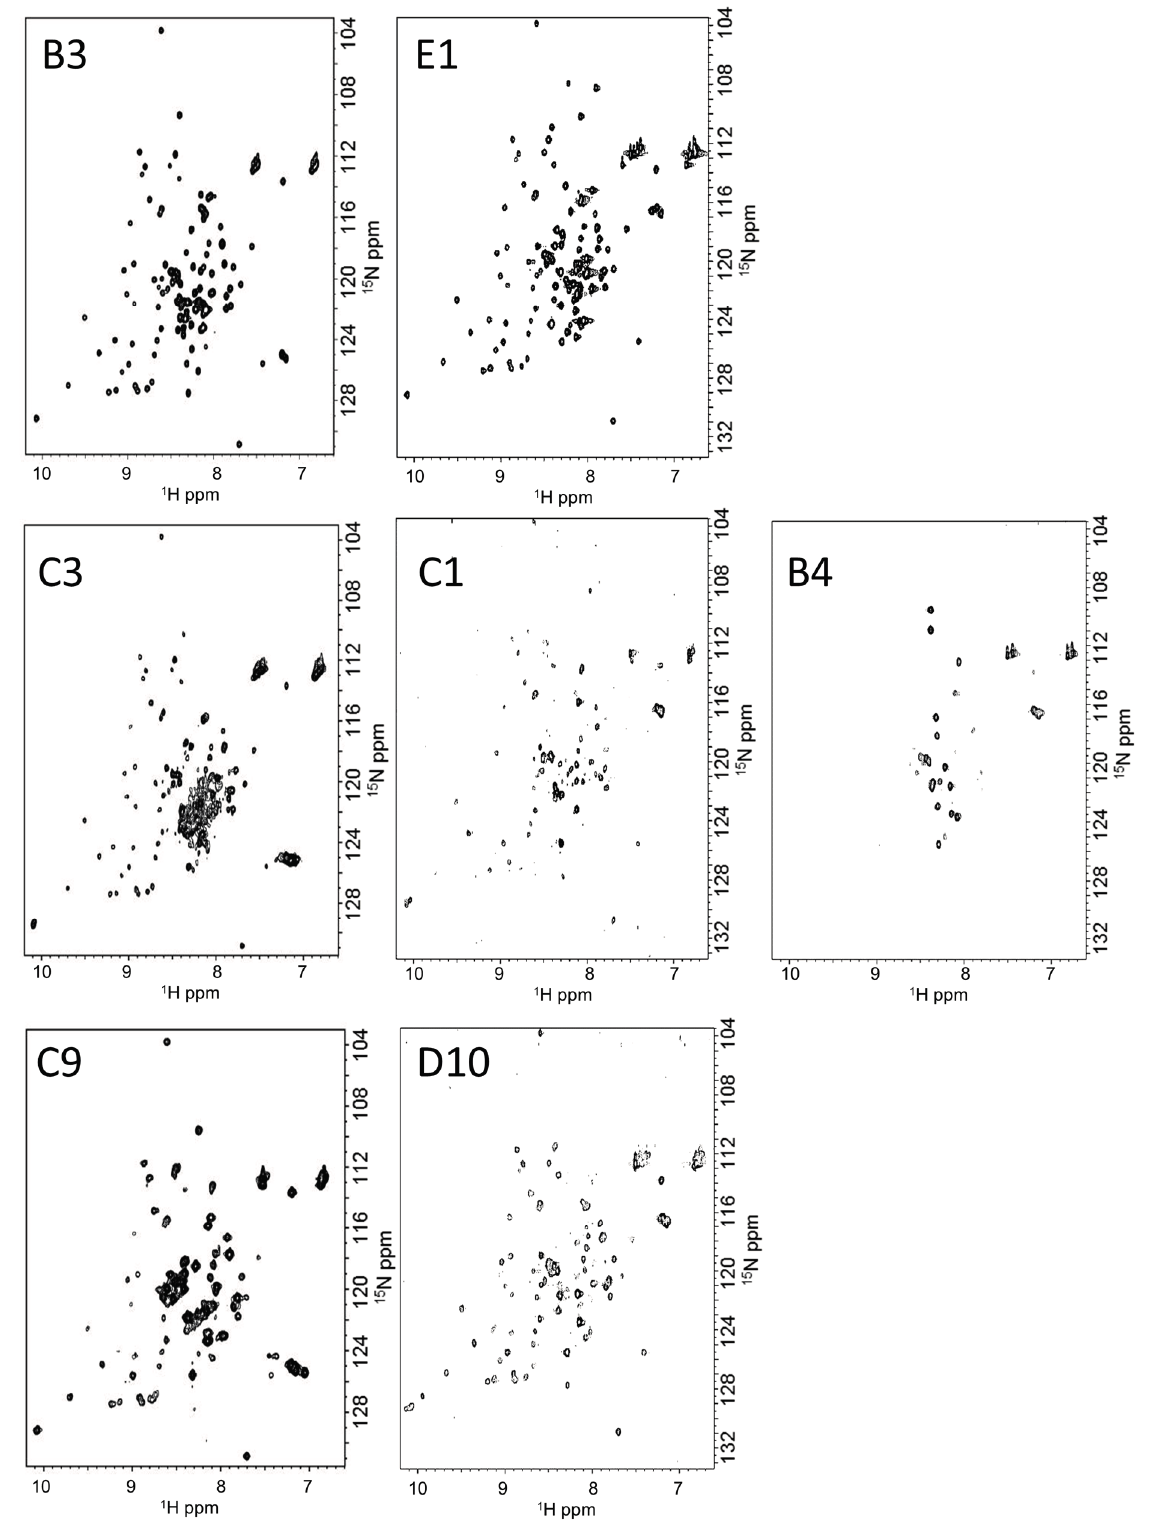
Figure 4. Examples of 2D 1 H- 15 N HSQC spectra of PH0471 chimeras with intrinsically disordered proteins (IDP). ( Top panels ) Examples of IDP linkers with high flexibility; ( middle panels ) Examples of inflexible IDP linkers; ( Bottom panels ) Examples of IDP linkers with moderate